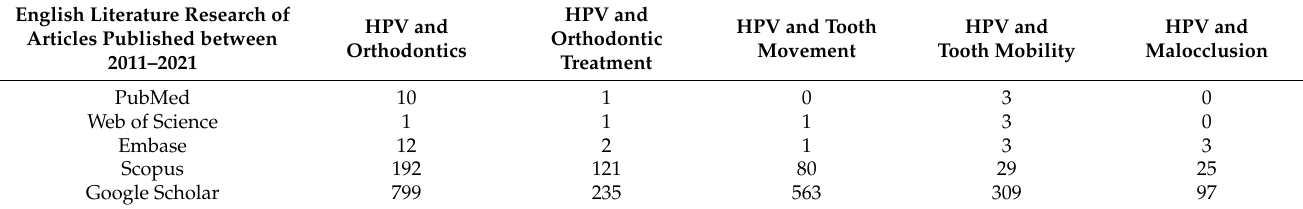
Table 2. English literature research of